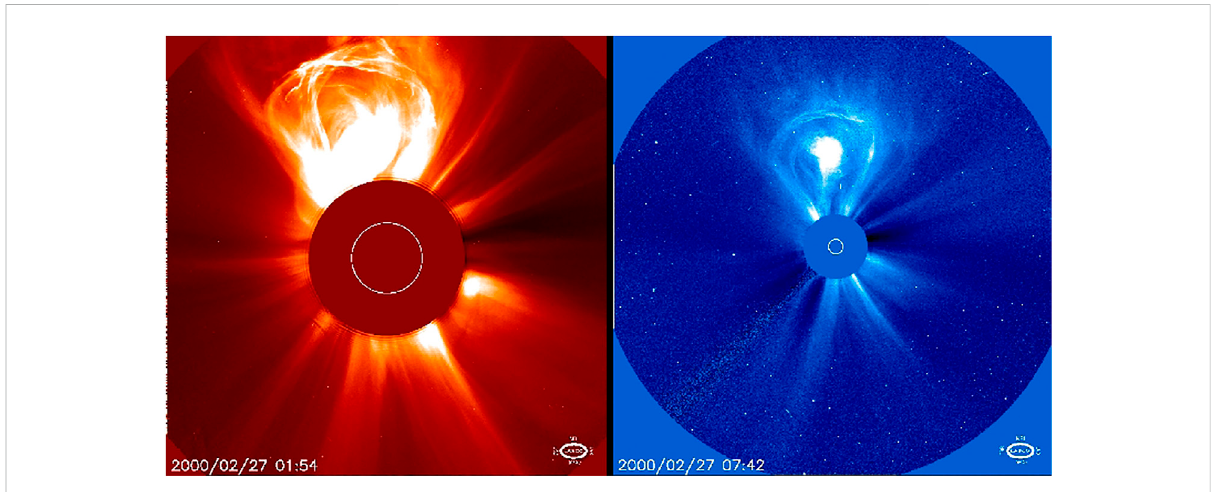
FIGURE 3 AnexampleofaCoronalMassEjection(CME).TheCMEgrowslargerasitmovesawayfromtheSunandbecomesanInterplanetaryCME(ICME). Images are taken by NASA ’ s SOHO on 27 Feb 2000. Credit: SOHO ESA and NASA. Source: https://www.nasa.gov/content/goddard/what-is-a-